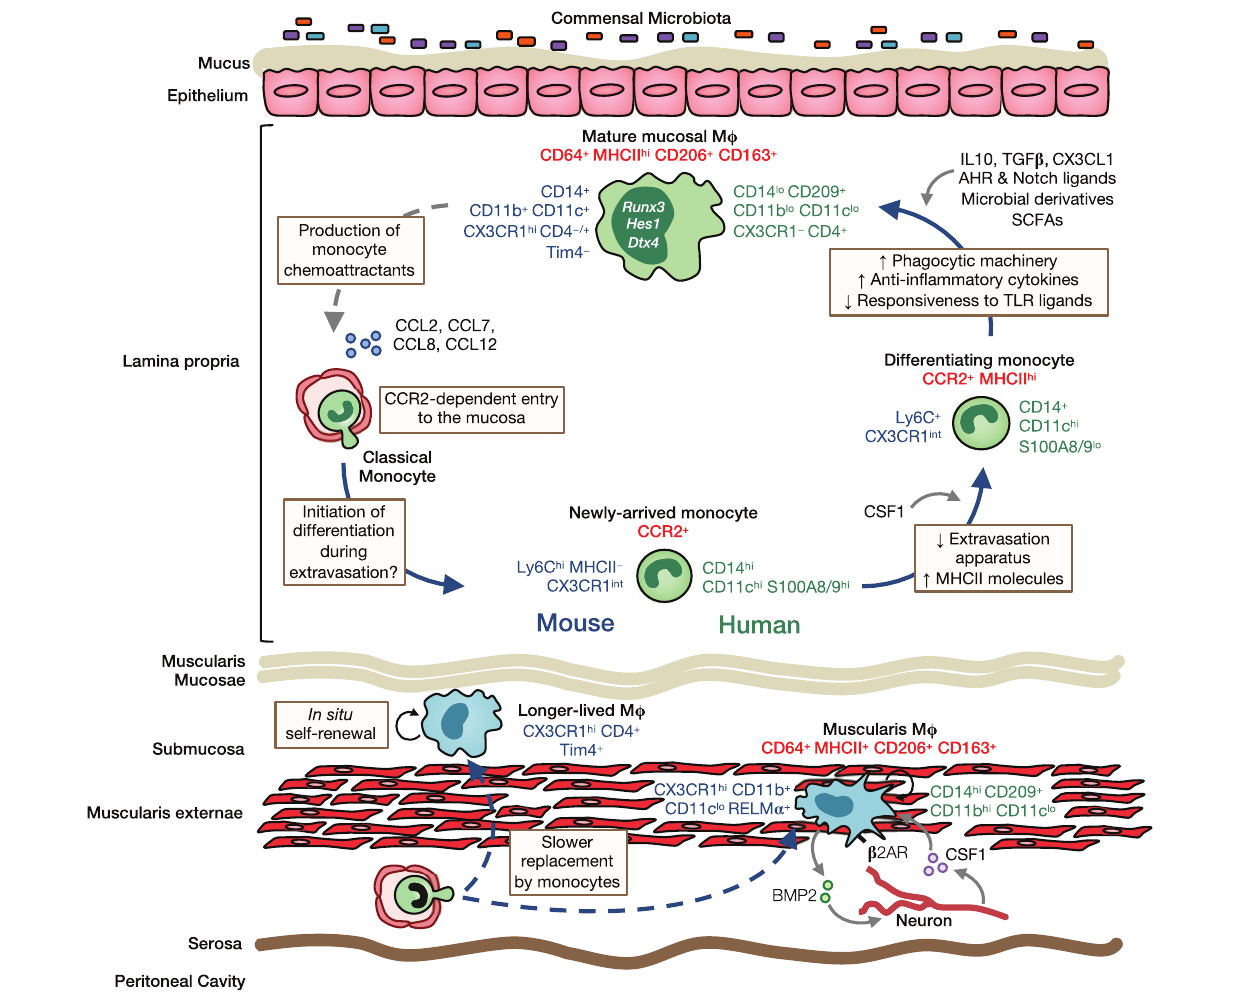
FIGURE 2 | Heterogeneity, origin and differentiation of intestinal macrophages. The majority of mucosal macrophages are replenished by classical monocytes that enter the mucosa in a CCR2-dependent manner and differentiate through a series of intermediaries (mouse-and human-specific markers denoted in blue and green, respectively) to give rise to mature macrophages, which can be identified in both mouse and man as CD64 + MHCII hi CD206 + CD163 + cells (common markers denoted in red). In addition, high levels of CD11b, CD11c, CD14, and CX3CR1 are characteristic features of murine LP macrophages. In contrast, human LP macrophages express only low levels of most of these markers but express high levels of CD209. Once in the mucosa and under cues from the local environment, monocytes first upregulate MHCII and downregulate molecules involved in extravasation, such as CCR2, LFA-1 and CD62L. They then upregulate phagocytic receptors and increase their production of anti-inflammatory cytokines, as well as becoming hyporesponsive to stimulation through e.g., TLRs. Studies in mice have identified IL10, TGF β , and CX3CL1 as key factors in promoting macrophage differentiation in the healthy mucosa. Furthermore, exposure to the microbiota and its metabolites is known to influence macrophage differentiation and the rate of their turnover in the LP. Mature macrophages may also regulate their own turnover through secretion of monocyte chemoattractants, such as CCL2, CCL7, CCL8, and CCL12. Longer-lived macrophages may also exist in the murine intestinal mucosa and submucosa, and can be identified by their expression of the phagocytic receptor Tim4. While sharing certain features with their LP counterparts, such as CD64, MHCII, CD206, and CD163 expression, muscularis macrophages have a relatively distinct phenotype. In mouse, they express low levels of CD11c but high levels of the immunoregulatory cytokine RELM α , whereas in man, they have high levels of CD14 and CD11b. Muscularis macrophages are acutely dependent on CSF1 and norepinephrine signaling by sympathetic neurons via β 2 adrenergic receptors ( β 2AR) shapes their differentiation. Monocytes also replenish macrophages of the muscularis, although the rate of replenishment is slower than in the mucosa and a larger proportion of these macrophages are